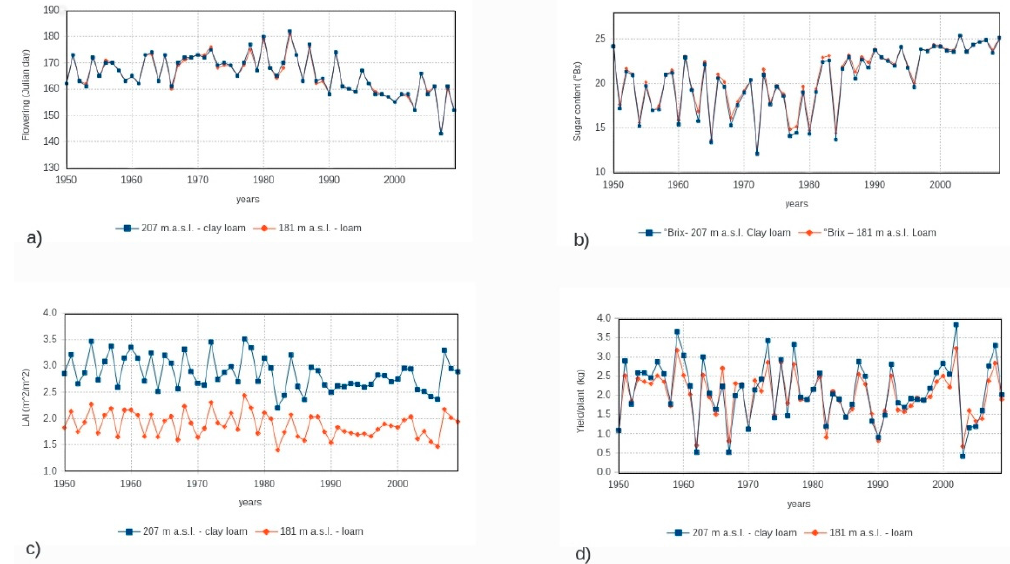
Figure 8. Flowering date (expressed in Julian days) ( a ), berry sugar content at the date of 287th Julian day (expressed in ◦ Bx) ( b ), LAI maximum value (expressed in m 2 m − 2 ) ( c ), and yield per vine (expressed in kg) ( d ), simulated by IVINE in two grid points characterized by different soil texture. Cv.: Nebbiolo.